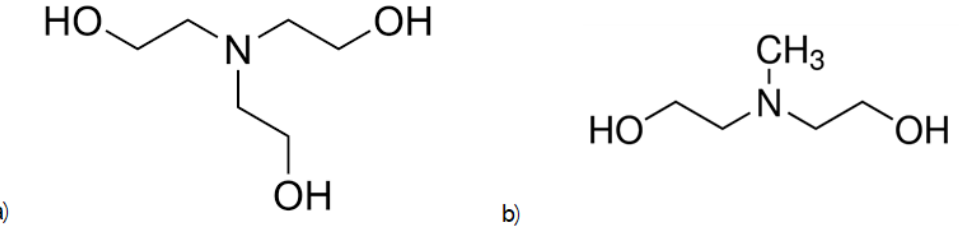
Figure 1. Structure of the studied initiators. ( a ) triethanolamine (TEA) and ( b ) methyldiethanolamine (MDEA).